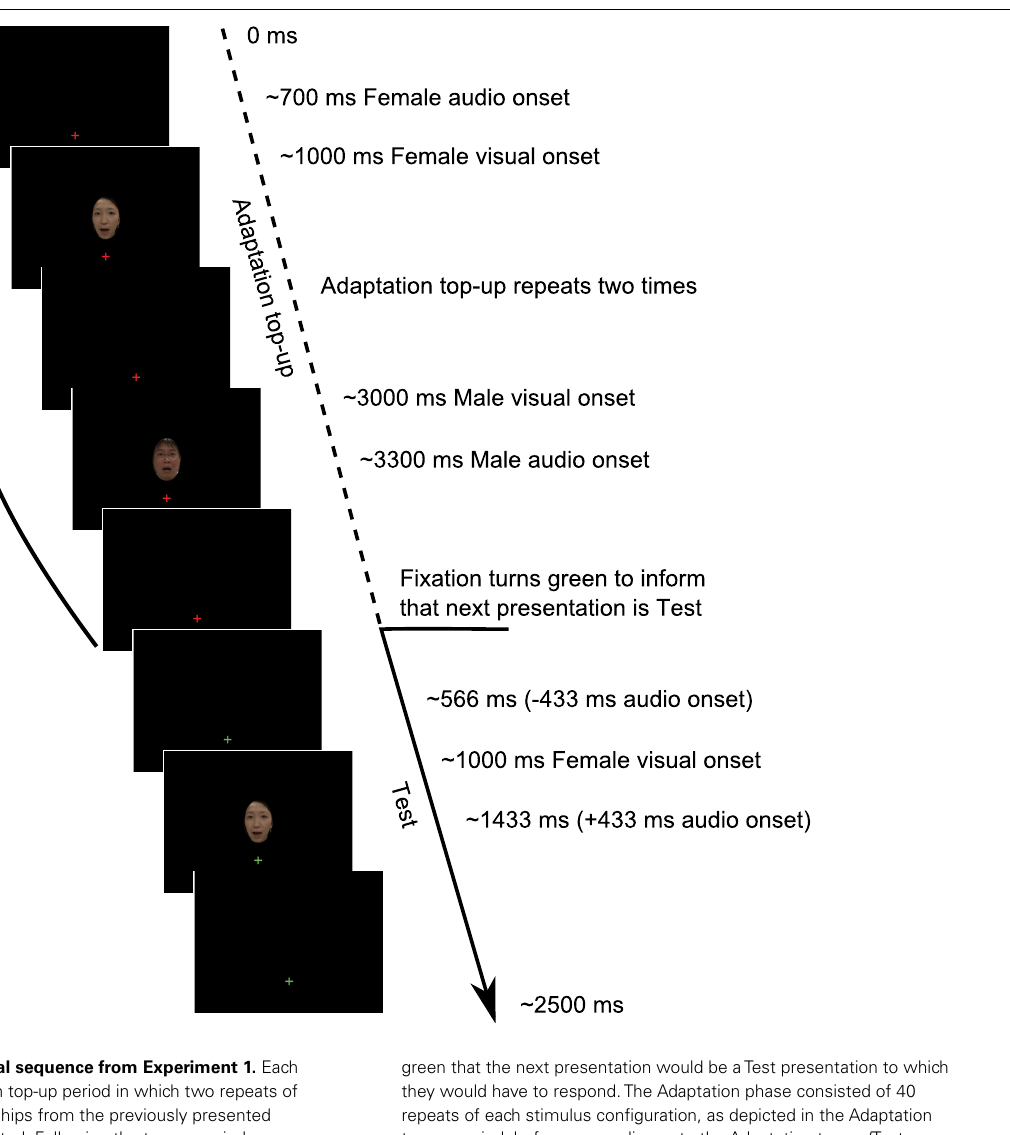
green that the next presentation would be aTest presentation to which they would have to respond.The Adaptation phase consisted of 40 repeats of each stimulus configuration, as depicted in the Adaptation top-up period, before proceeding onto the Adaptation top-up/Test presentation